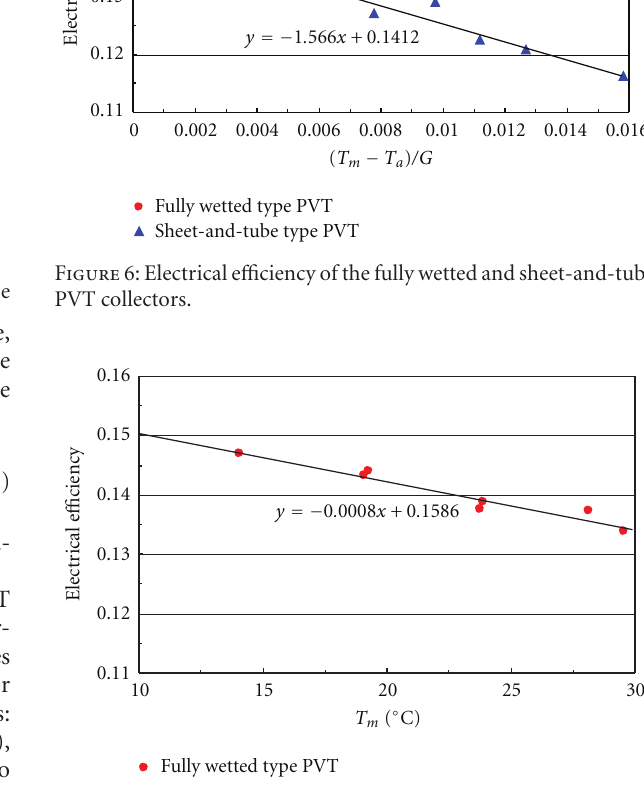
Figure 7: Electrical e ffi ciency of the fully wetted PVT collector as a function of the mean fluid